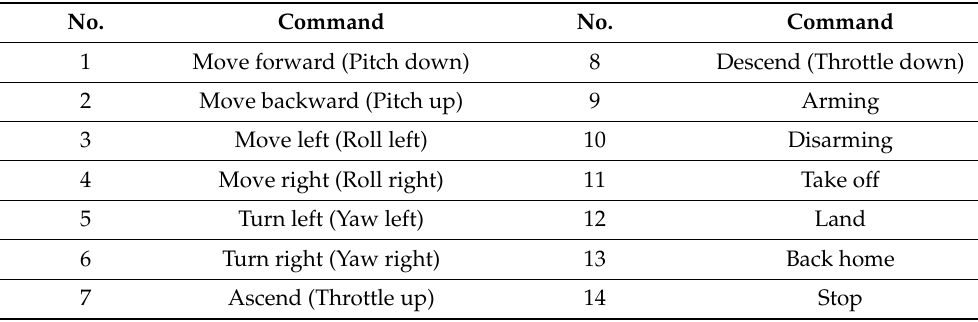
Table 2. Command list considering joystick-based multi-copter direct operation instructions and proposed